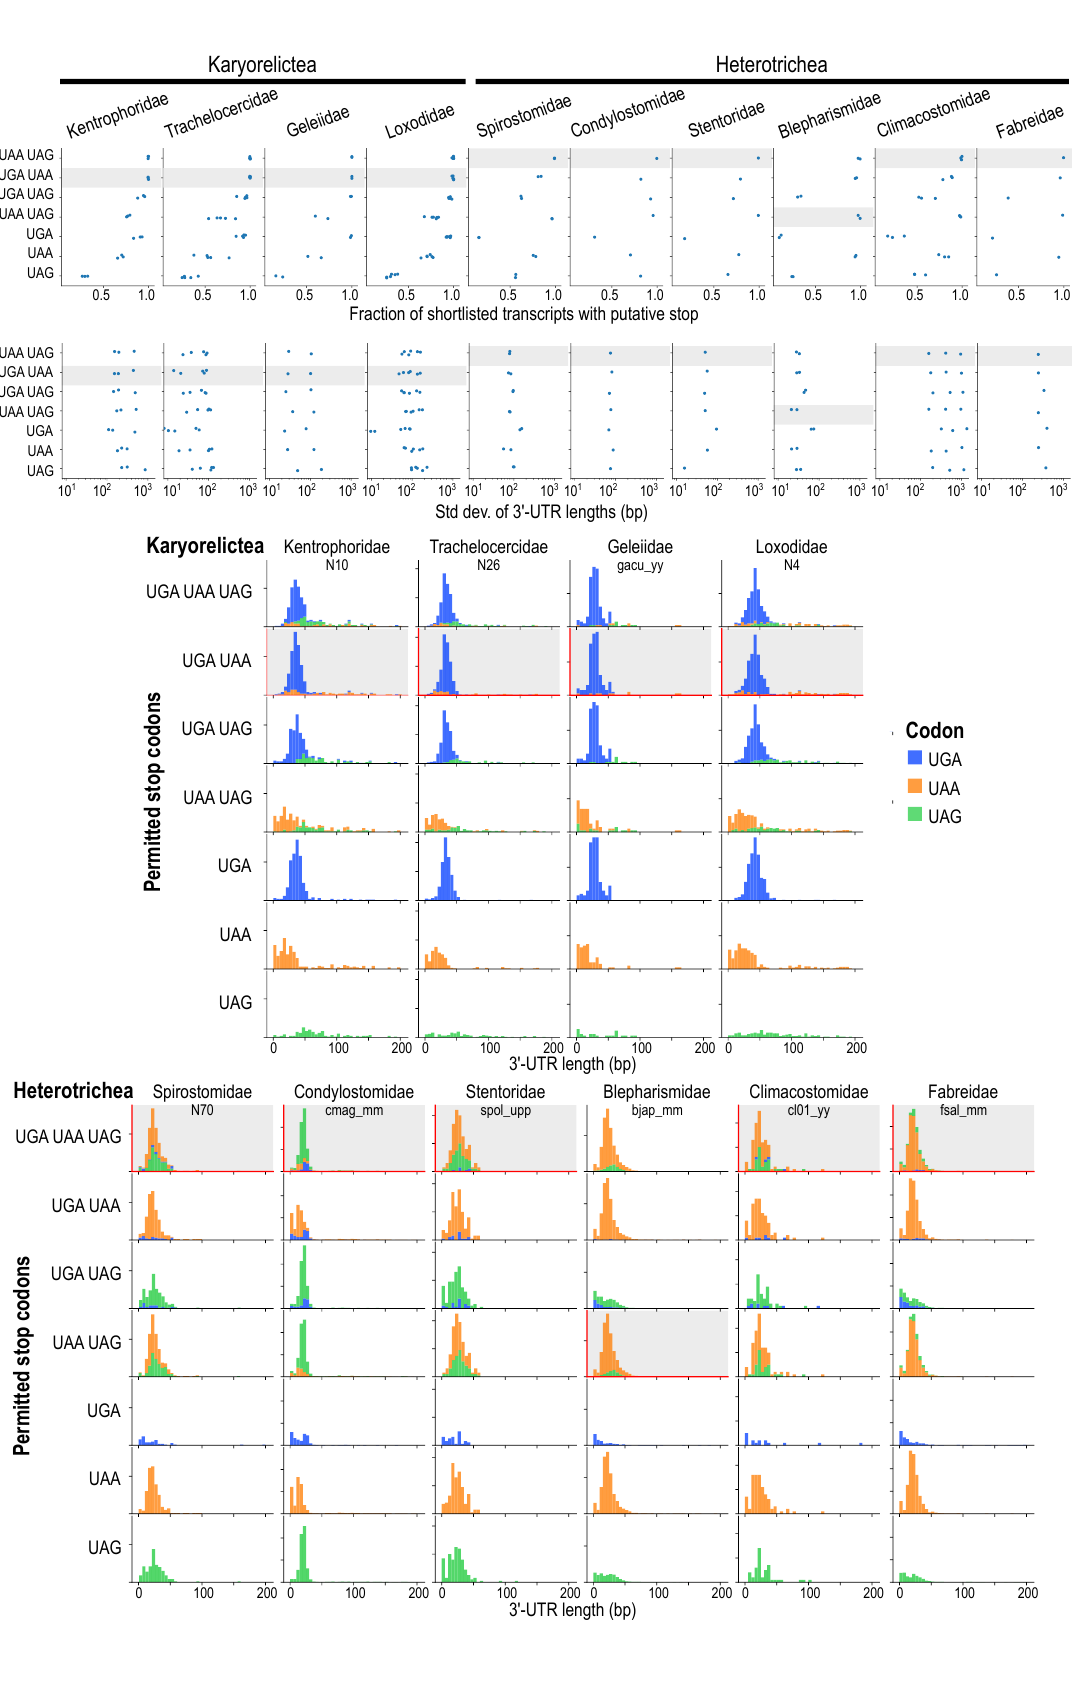
Fraction of shortlisted transcripts with putative stop